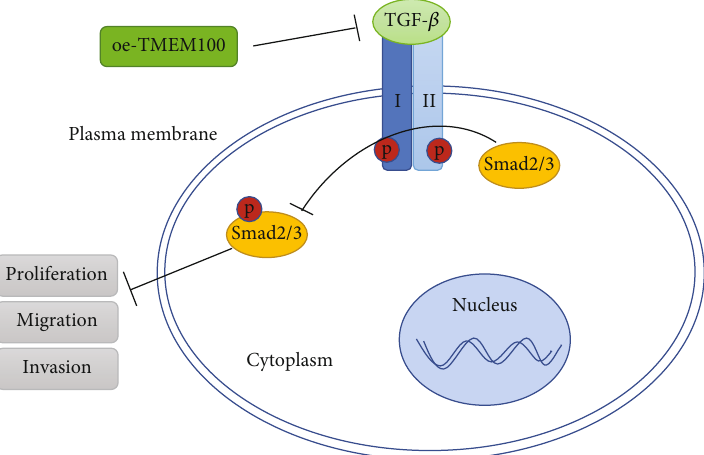
Figure 5: Mechanism diagram of TMEM100 inhibiting CRC. TMEM100 inhibits TGF- β activation by suppressing the interaction between TGF- β ligand and its homology type I and type II one-way transmembrane receptors, thereby inhibiting its Smad2/Smad3 phosphorylation. Ultimately, progression of CRC cells was hampered. Red circles represent phosphorylation. I and II represent TGF- β type I and type II receptors,